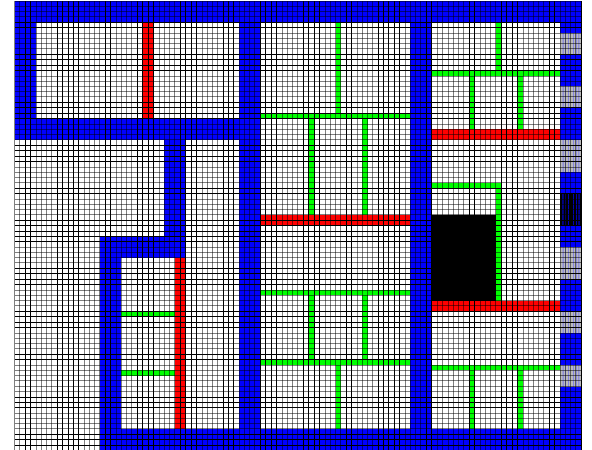
Figure 13. First proposed subdivision schema for the adaptive reuse project.